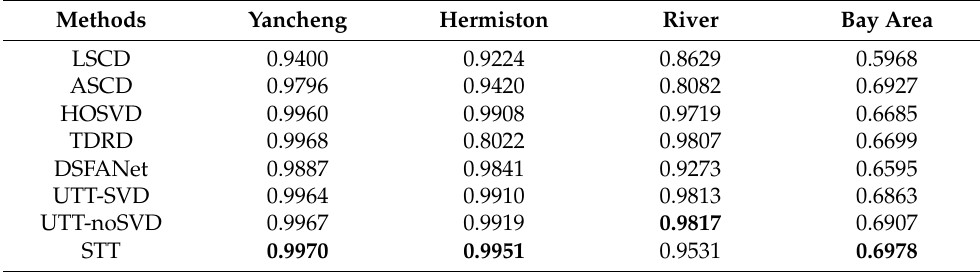
Table 2. Evaluation of AUC values for different